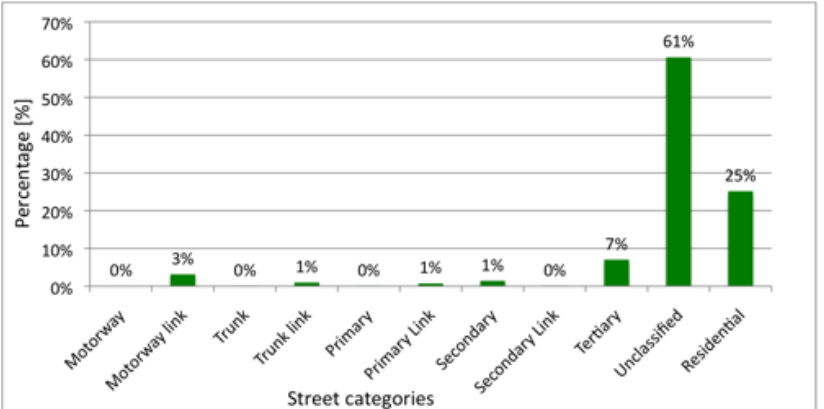
Figure 6. Distribution of Streets without Name or Route Number Attribute Information by Street Category (June